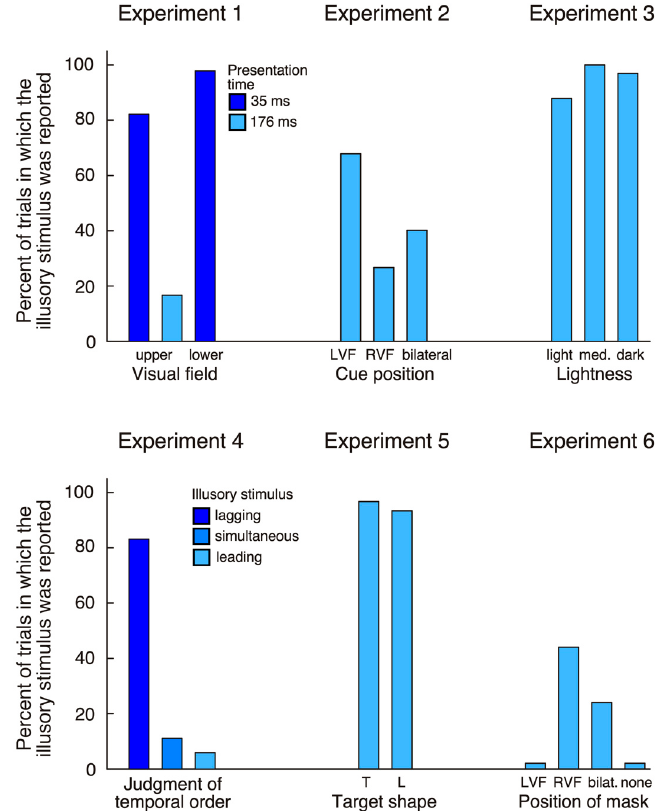
Figure 2. Summary of the findings of all six experiments. Vertical bars show the percentage of responses when HG reported the presence of a stimulus in the left visual field, as a function of the type of stimulus shown in his right visual field. Experiment 1: right target shown in the upper (35 ms and 176 ms) or lower visual field (35 ms); experiment 2: right target, with cue in the left/right visual field or bilateral cues; experiment 3: right target at three levels of lightness; experiment 4: right target; experiment 5: right target is a T or L; experiment 6: right target with left mask, right mask, bilateral mask or no mask (LVF/RVF: left/right visual field).